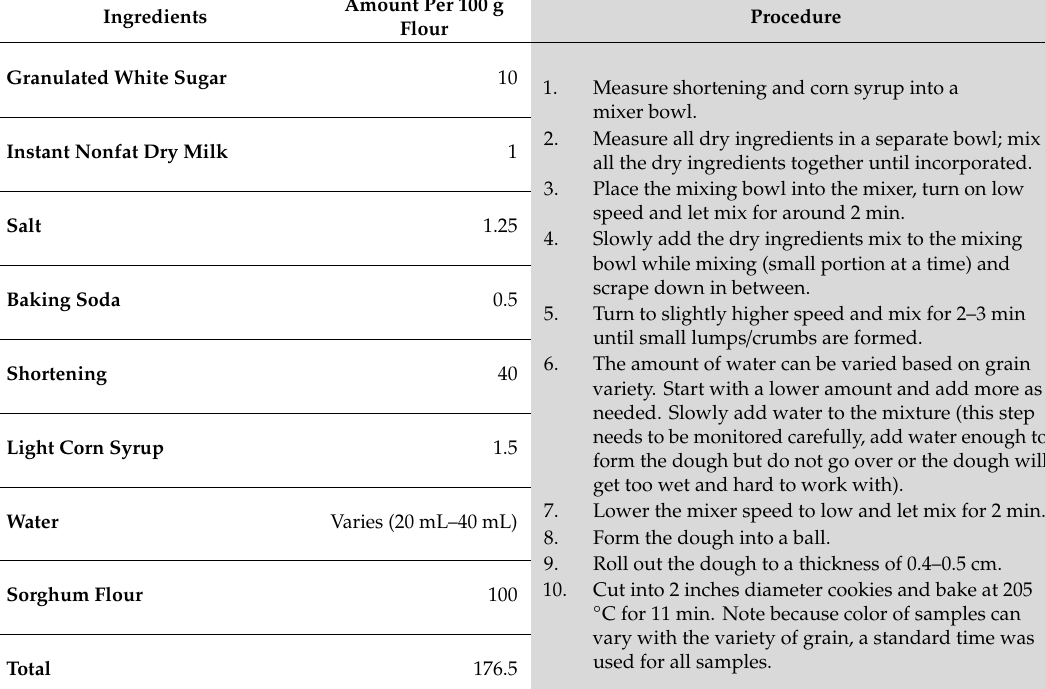
Table 3. Cookie recipe and